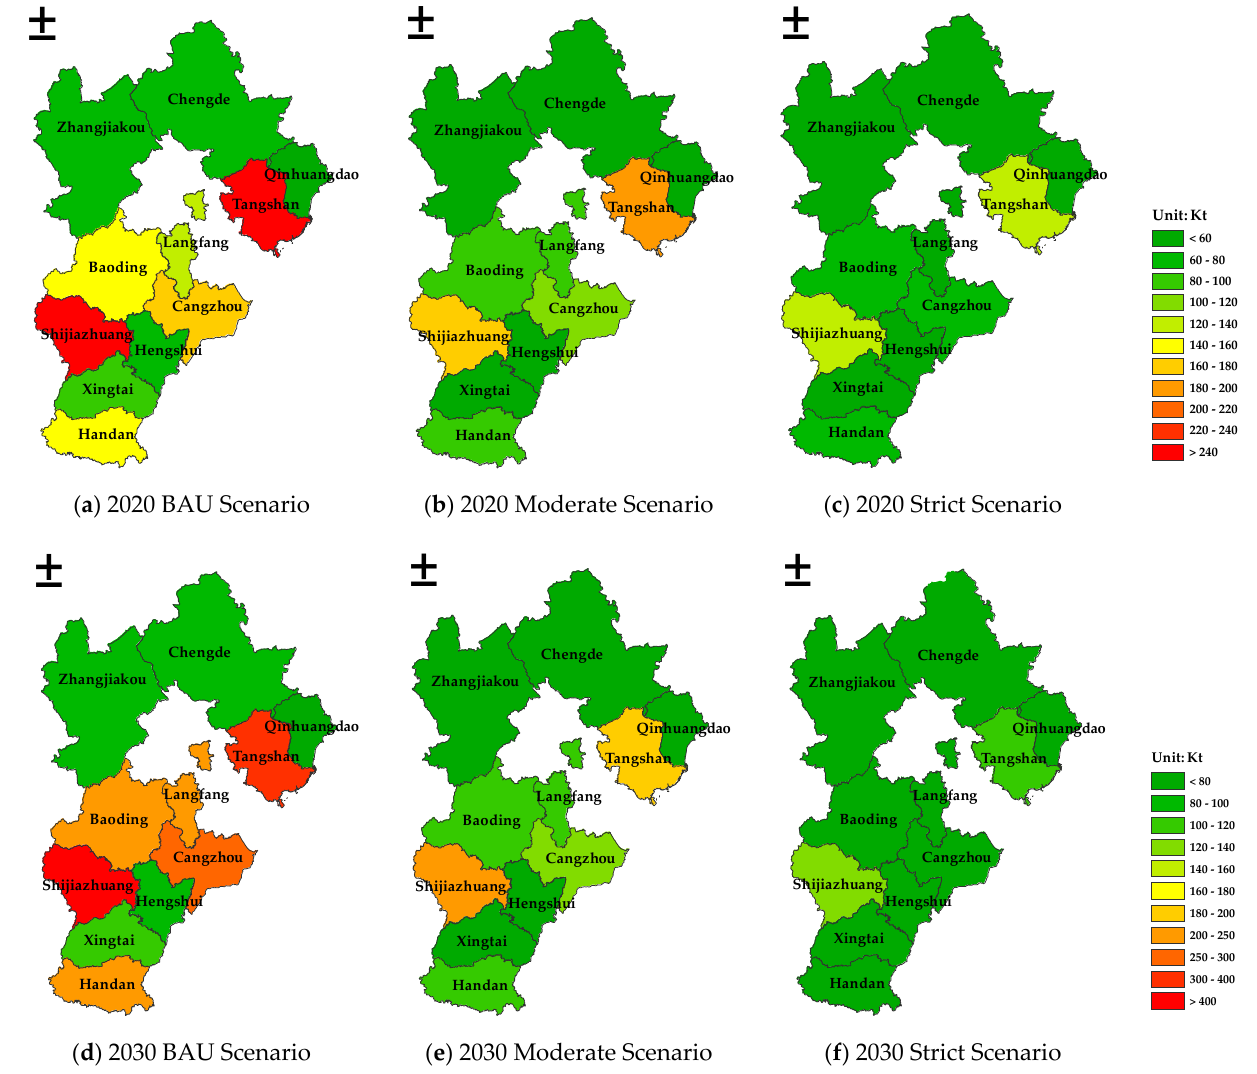
Figure 7. S patial distribution of VOC emissions from industrial sources in Hebei Province for 2020 and 2030.